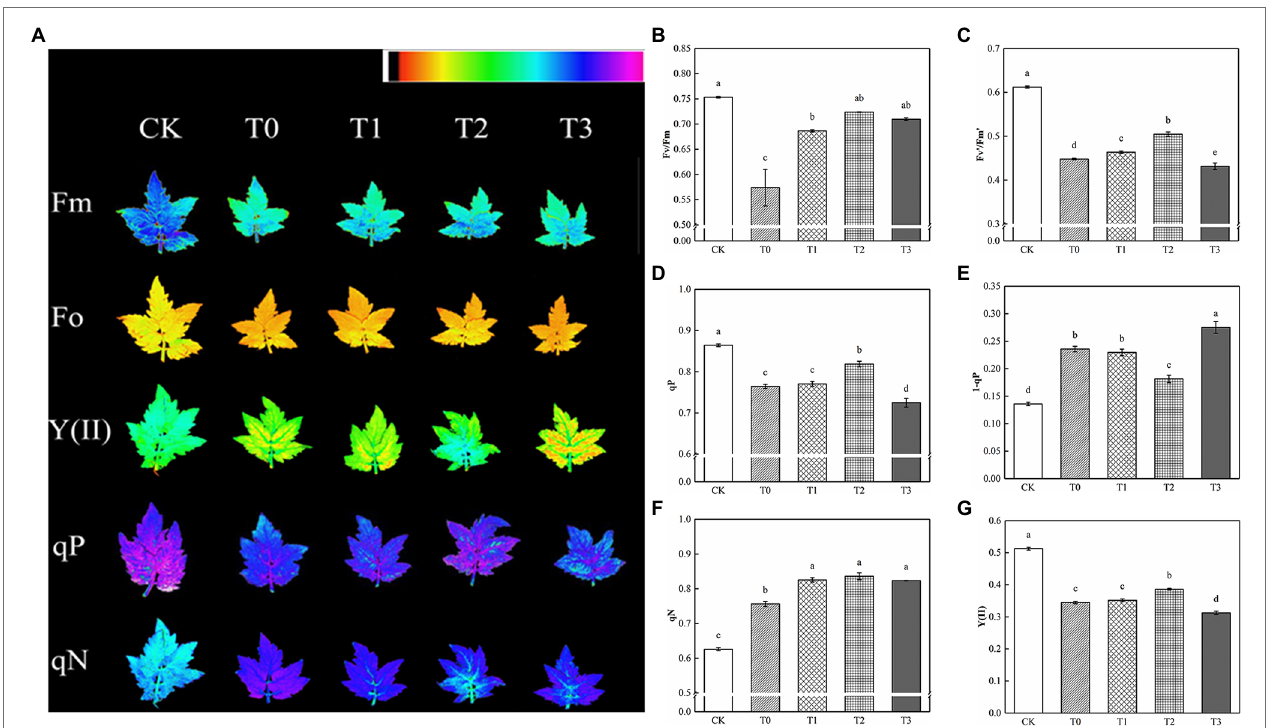
FIGURE 3 | Effect of different concentrations of trehalose on the chlorophyll fluorescence parameters of tomato leaves. Data were recorded after 5 days of treatment. (A) Images of Fm, Fo, Y(II), qP and qN. These false colors are used to represent values of the parameter ranging from 0 (black) to 1.0 (purple). (B) Maximum efficiency of PSII photochemistry (Fv/Fm). (C) Efficiency of excitation energy captured by open PSII reaction centers (Fv ′ /Fm ′ ). (D) Coefficient of photochemical quenching (qP). (E) PSII excitation pressure (1-qP). (F) Coefficient of non-photochemical quenching (qN). (G) Actual PSII efficiency (Y(II)). The results showed the mean ± SE of three replicates, and the different letters denote the significant difference among treatments ( p < 0.05), according to Duncan’s multiple test. CK, control; T0, 150 mM NaCl; T1, 150 mM NaCl +5 mM trehalose; T2, 150 mM NaCl +10 mM trehalose; T3, 150 mM NaCl +25 mM trehalose.